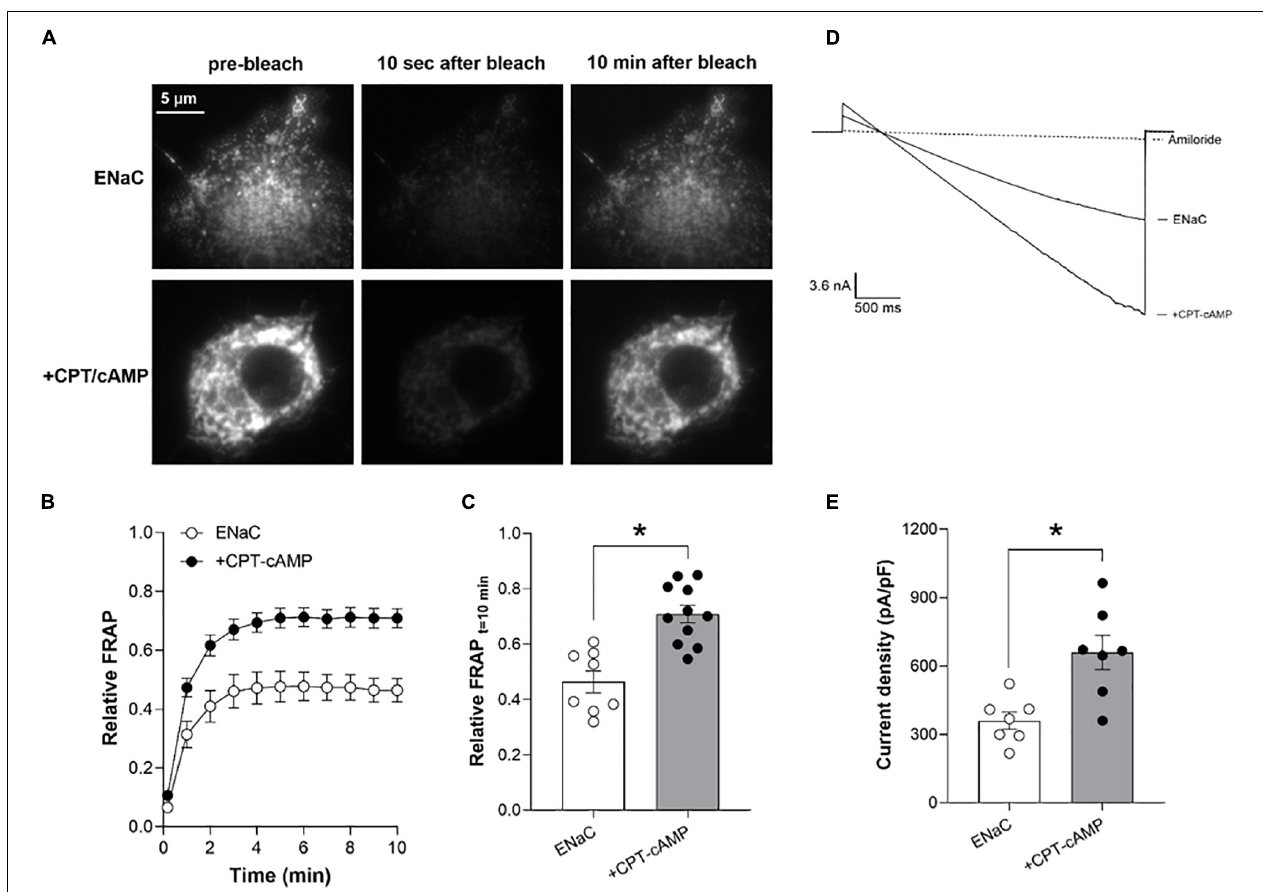
FIGURE 4 | cAMP signaling increases ENaC expression in the plasma membrane to increase channel activity. (A) Representative fluorescence micrographs of the plasma membranes of COS-7 cells expressing recombinant eYFP-ENaC in the absence (top) and presence of CPT-cAMP (bottom) prior to photobleaching (left) and 10 s (middle) and 10 min (right) after photobleaching. Images were collected with TIRF microscopy. (B) Time courses of relative FRAP at the plasma membrane for cells expressing eYFP-ENaC in the absence (white circles, n = 8) and presence of CPT-cAMP (200 mM; black circles; n = 11). Summary data from experiments identical to those shown in (A) . (C) Summary graph of relative FRAP 10 min after photobleaching in cells expressing eYFP-ENaC in the absence (white circles, white bar) and presence of CPT-cAMP (black circles, gray bar). Summary data from experiments identical to those shown in (A) . * P < 0.05 vs. no CPT-cAMP. (D) Overlays of typical macroscopic current traces from representative CHO cells expressing recombinant mouse ENaC in the absence and presence of CPT-cAMP (200 mM) and after adding 10 mM amiloride (dotted lines). Currents elicited by voltage ramps stepped from a holding potential of 40–60 mV and ramped to –100 mV. (E) Summary graph of ENaC activity (amiloride-sensitive current density at –100 mV) quantified in whole-cell voltage clamped CHO cells transfected with mouse ENaC in the absence (white circles, white bar) and presence (black circles, gray bar) of CPT-cAMP treatment. Summary data from experiments ( n = 7) identical to those shown in (D) . * P < 0.05 vs. no